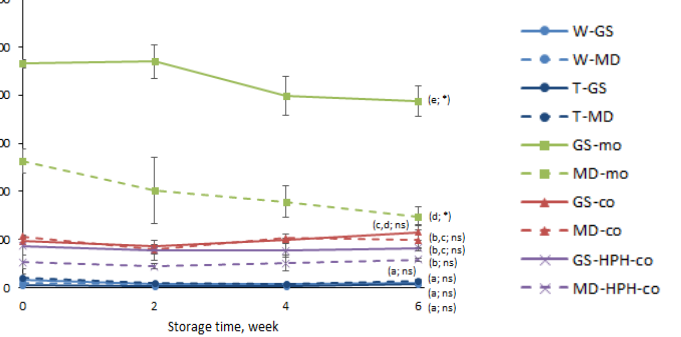
spray-drying or electrospraying (monoaxial and coaxial) during storage: 2-ethylfuran ( A ); 1-penten-3- Figure 6. Secondary volatile oxidation products (SVOPs) of the fish-oil-loaded capsules produced by